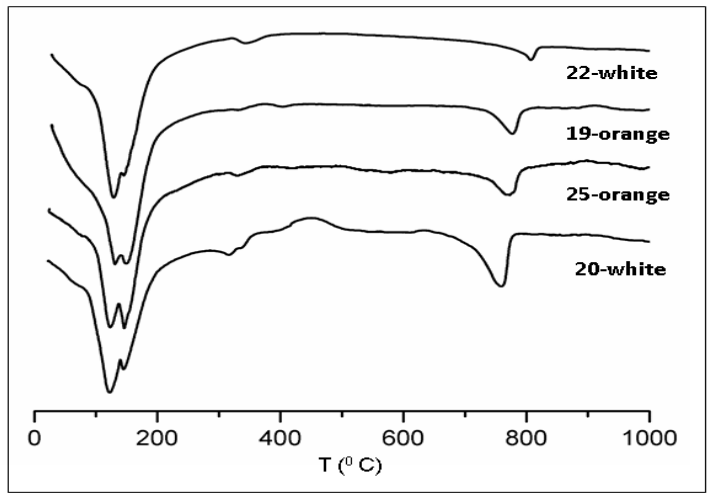
Figure 11. DTA curves for halotrichite (20-white) and pickeringite (19-orange, 22-white, 25-orange) samples.